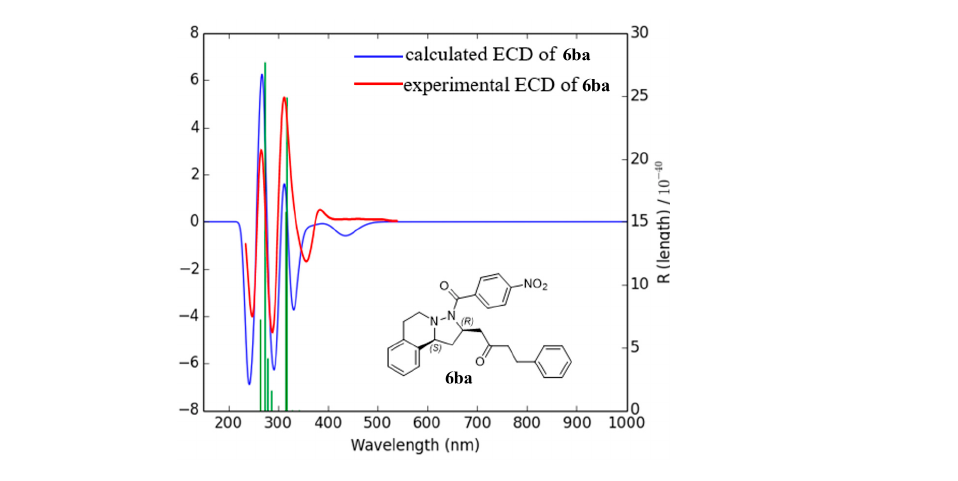
Figure 3. Comparison of the experimental ECD spectrum of chiral 6ba (the red line) with the calculated one of ( R , S )- 6ba (the blue line). The green line is the position of the peak in horizontal axis.